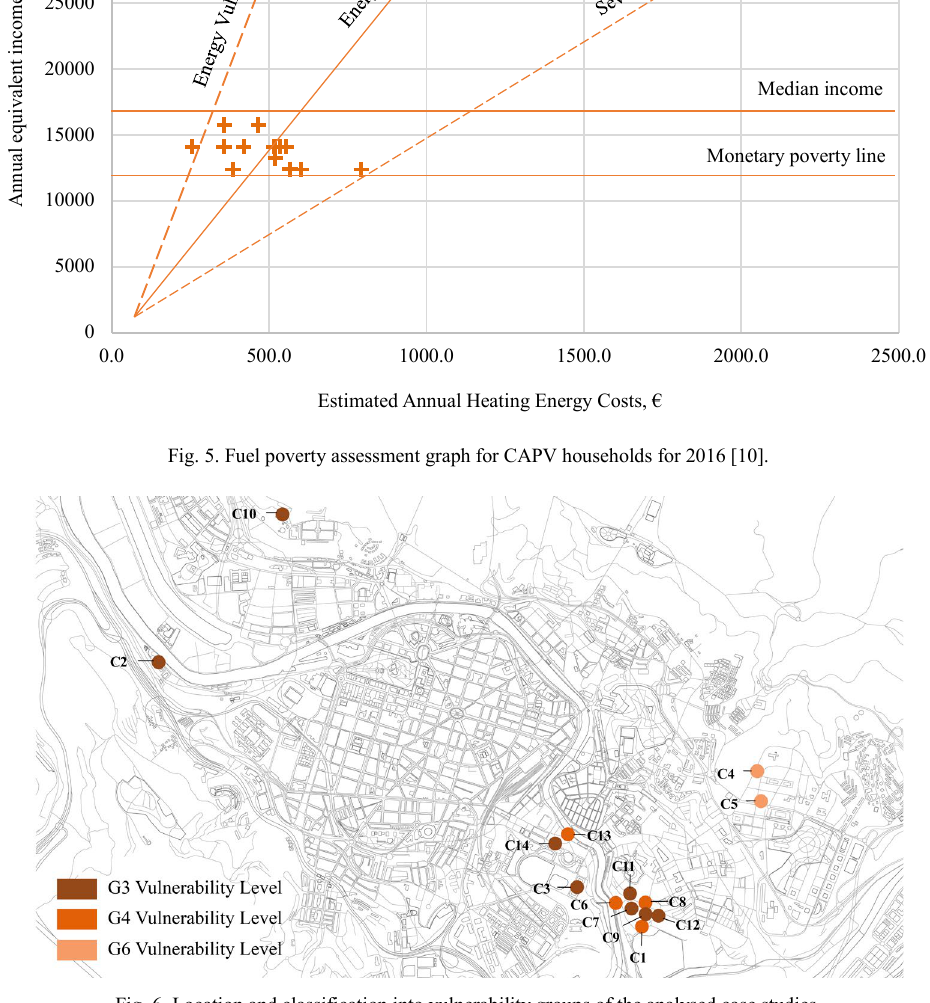
Fig. 6. Location and classification into vulnerability groups of the analysed case